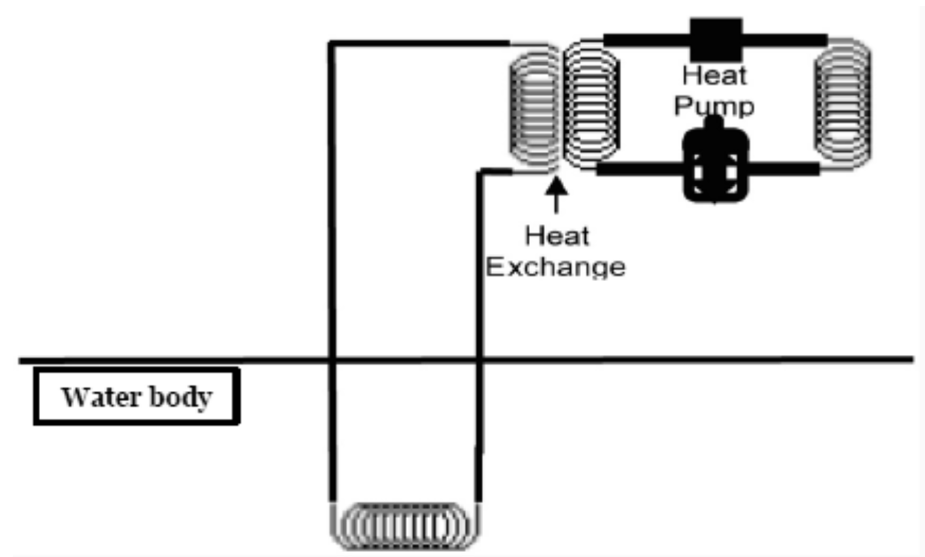
Figure 2. In closed loop geothermal heat pump system, in this picture in our installation, seawater was utilised as a heat source (modified from [8]).